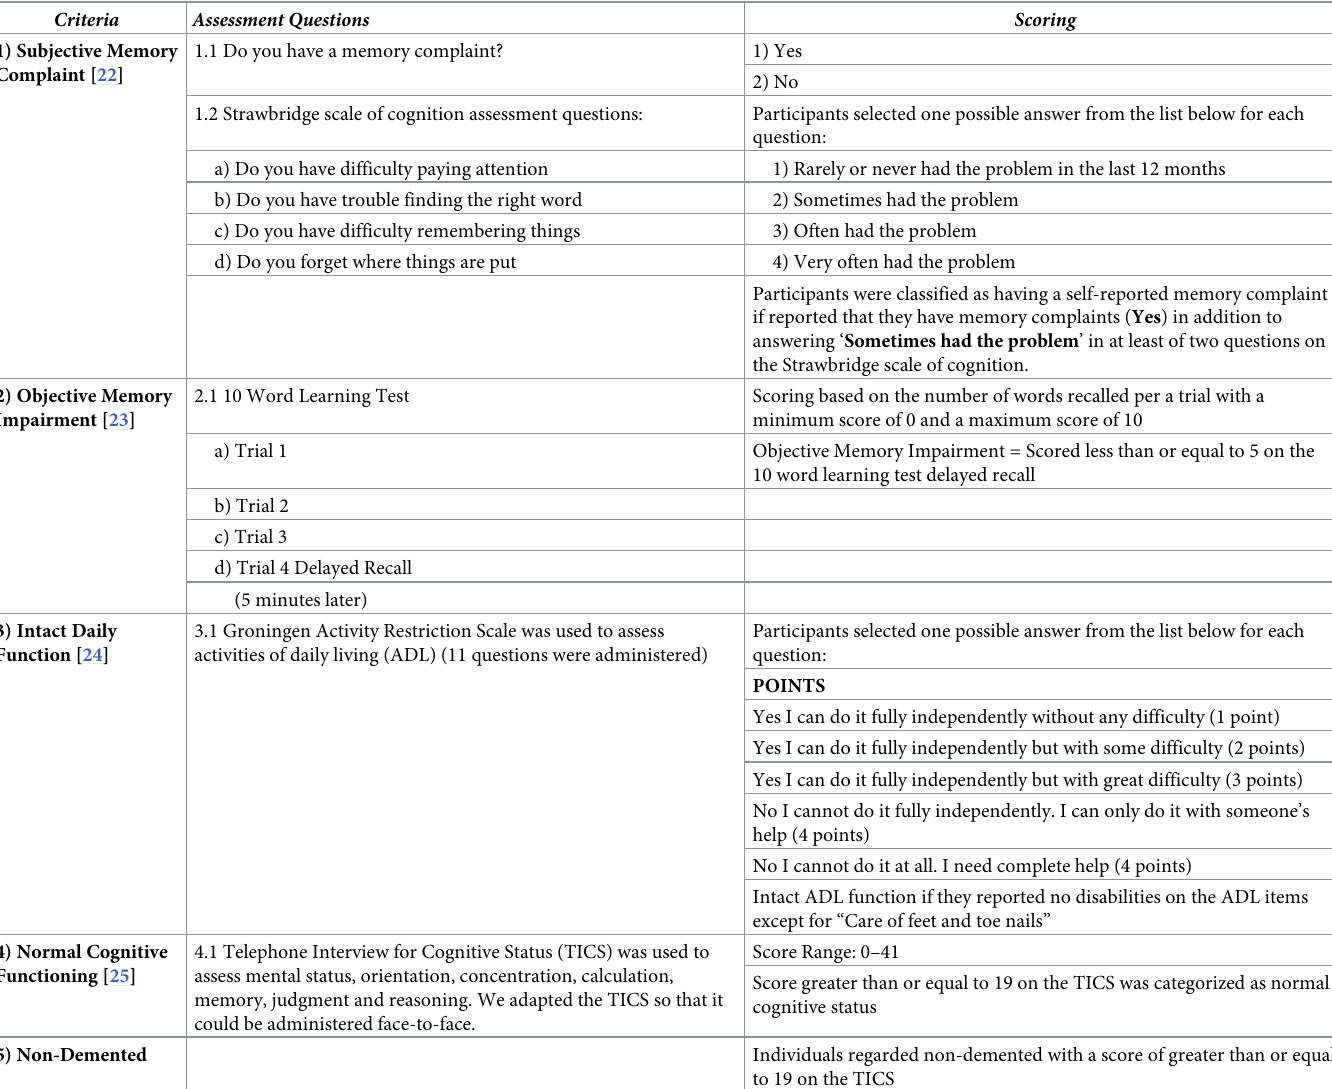
Table 1. Cognitive function screening